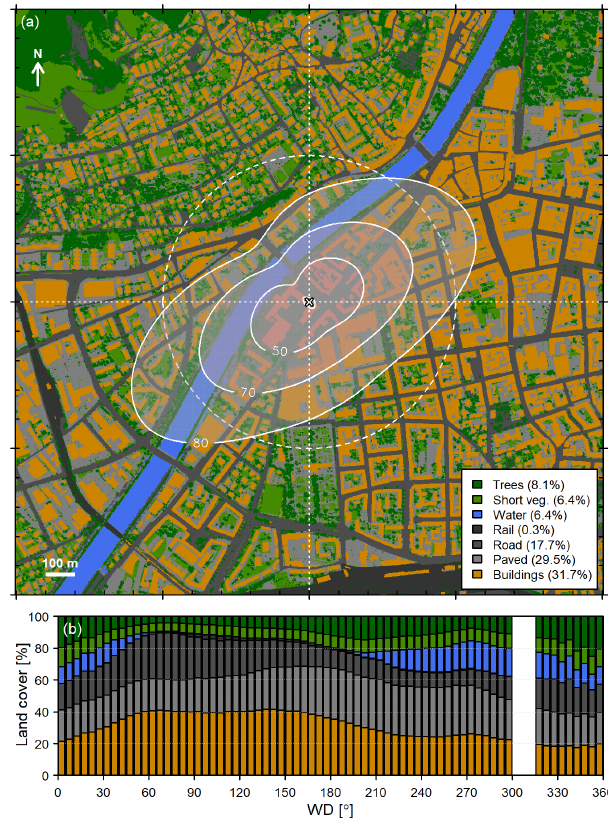
Figure 2. (a) Composite source area at IAO for the study period (1 May 2017–30 April 2021) superimposed on land cover (derived from various spatial datasets from Land Tirol, https://data.tirol.gv. at, last access: 17 May 2022). Contours indicate the region compris- ing 50%, 70% and 80% of the source area, and the circle indicates a distance of 500m from the flux tower. (b) Average land cover composition by wind direction (no data are available for wind di- rections of 309 ± 10 ◦ ; Sect. 2.3). The aggregated source area com- position for the study period is given in the